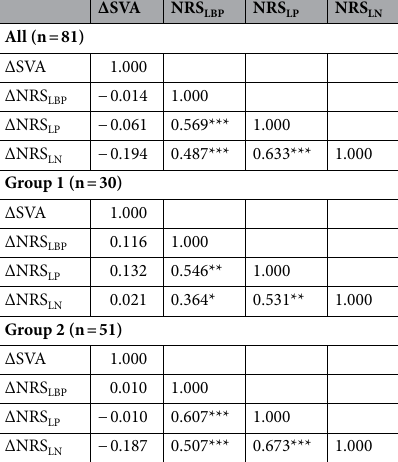
Table 5. Spearman correlations mean (Spearman’s r ) between ⊿ SVA and each pain score. SVA sagittal vertical axis, NRS numeric rating scale, NRS scores for low back pain (NRS LBP ), for leg pain (NRS LP ), and for leg numbness